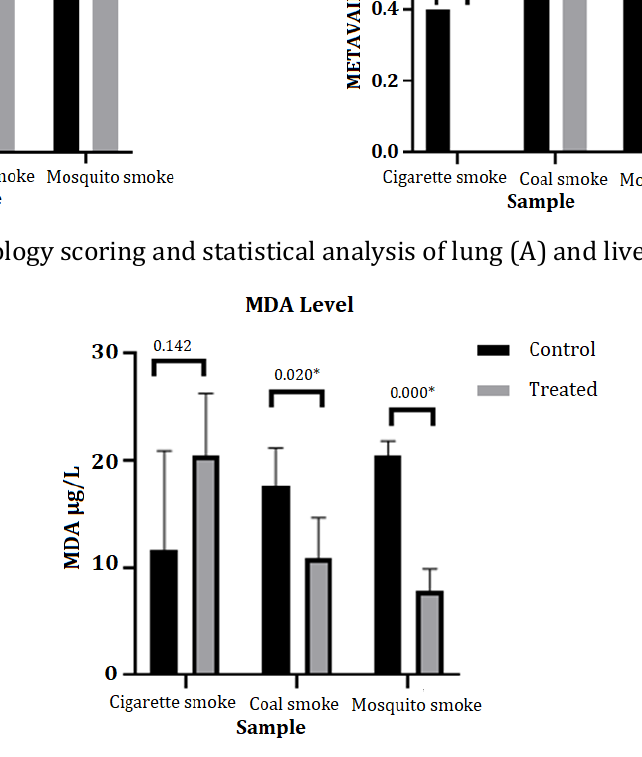
Figure 6. MDA level and statistical